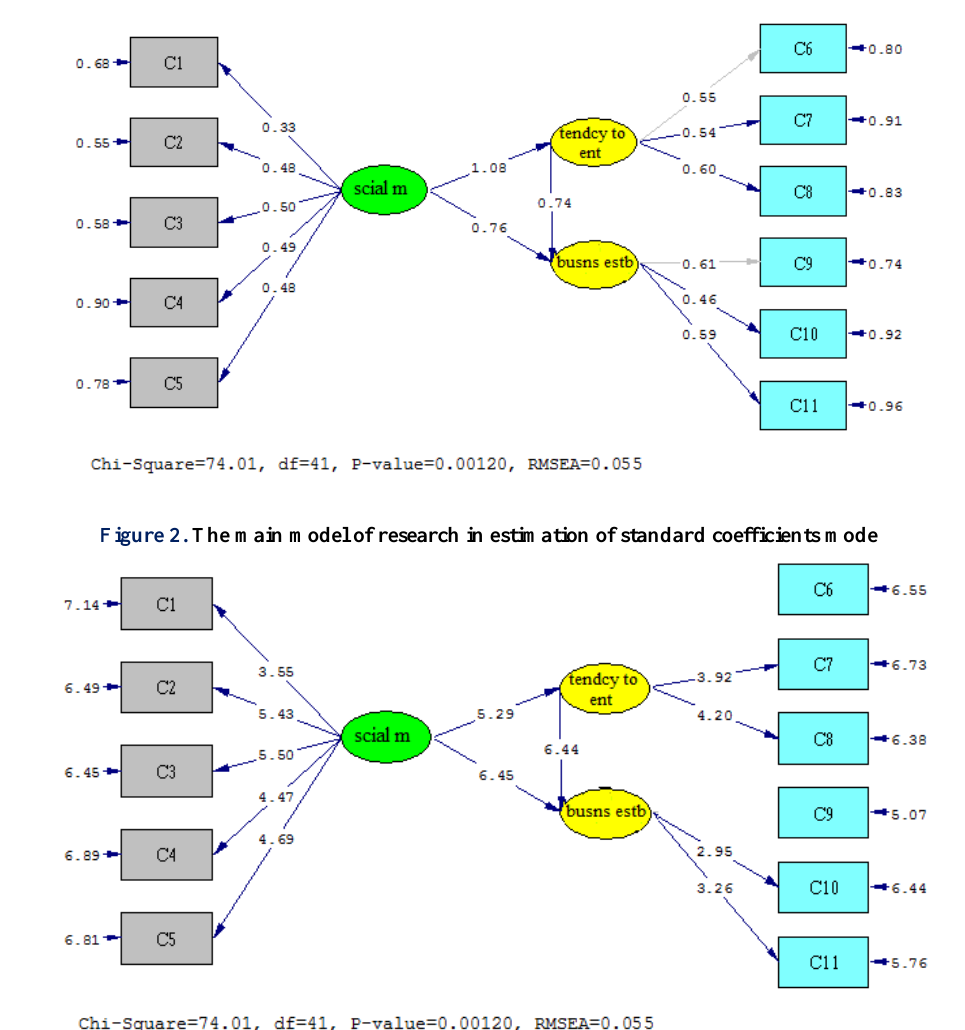
Figure 3. Structural equation model in meaningful mode